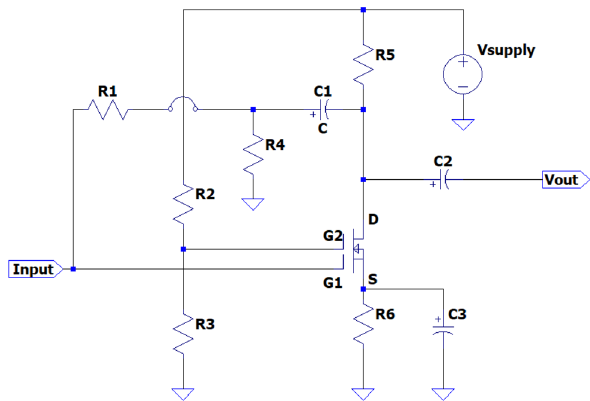
Fig. 4 Pseudo-schematic of common-source amplifier using DG